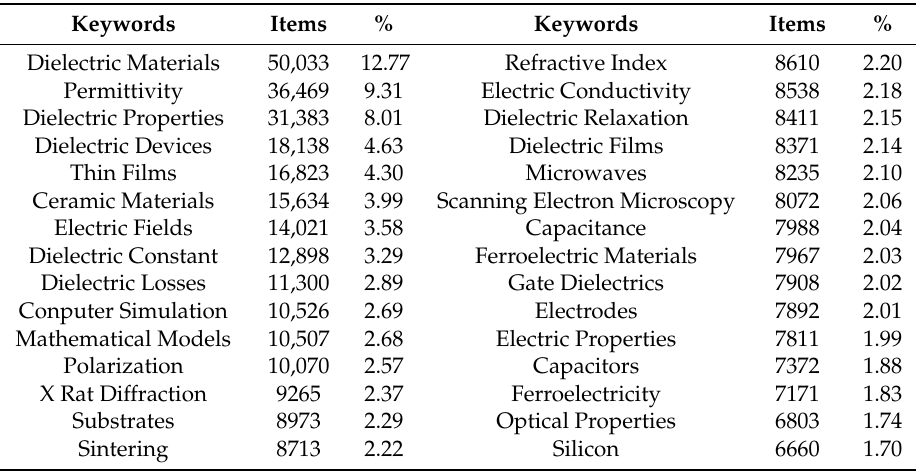
Table 3. Top 10 ranking journals in